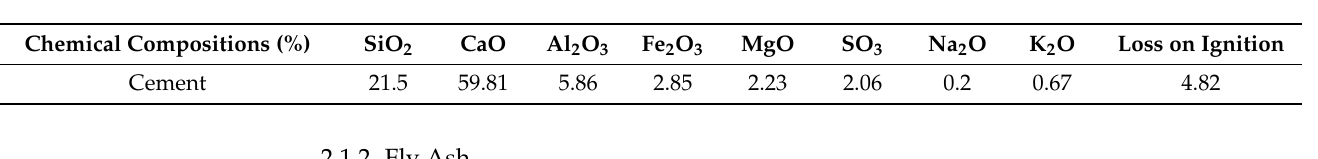
Table 2. Chemical compositions of cement.